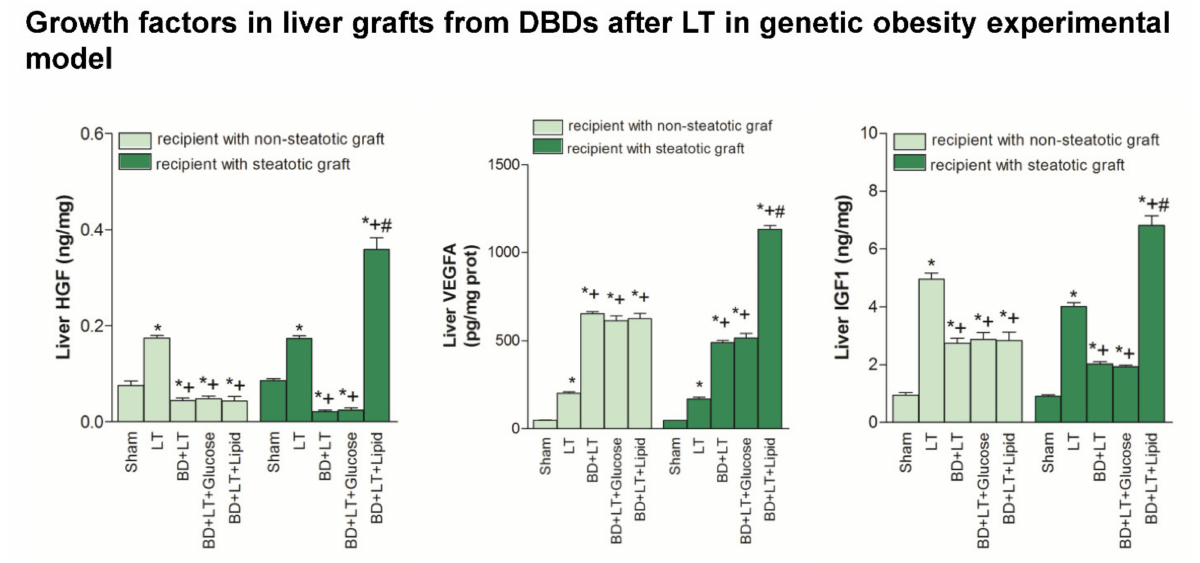
Figure 3. Effects of glucose and lipids on growth factors in steatotic and non-steatotic LT in a genetic obesity experimental model. HGF, VEGFA and IGF1 in liver. * p < 0.05 vs. Sham. + p < 0.05 vs. Liver Transplantation (LT). # p < 0.05 vs. Bran Death+Liver Transplantation (BD + LT). DBD, Donors after Brain